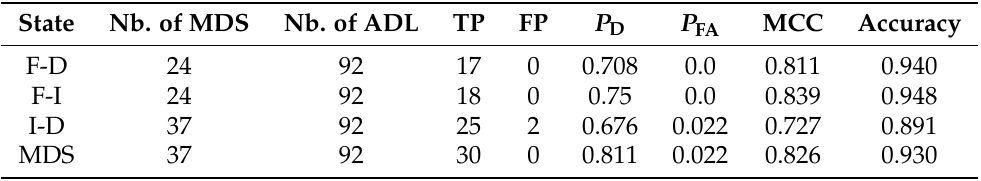
Table 4. Summary of workers physical tests